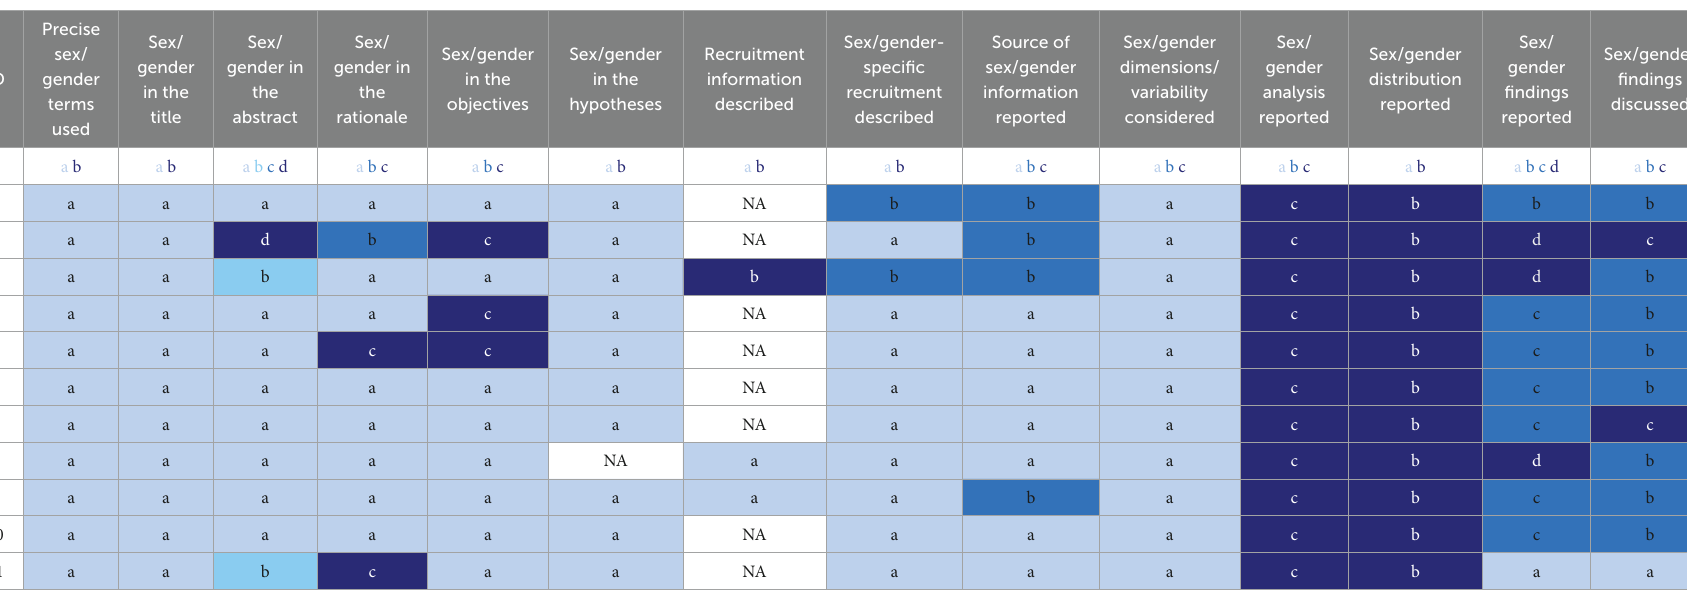
TABLE 3 Assessment matrix for the consideration of sex/gender in publications assessing sex/gender in the association between environmental noise and cardiovascular